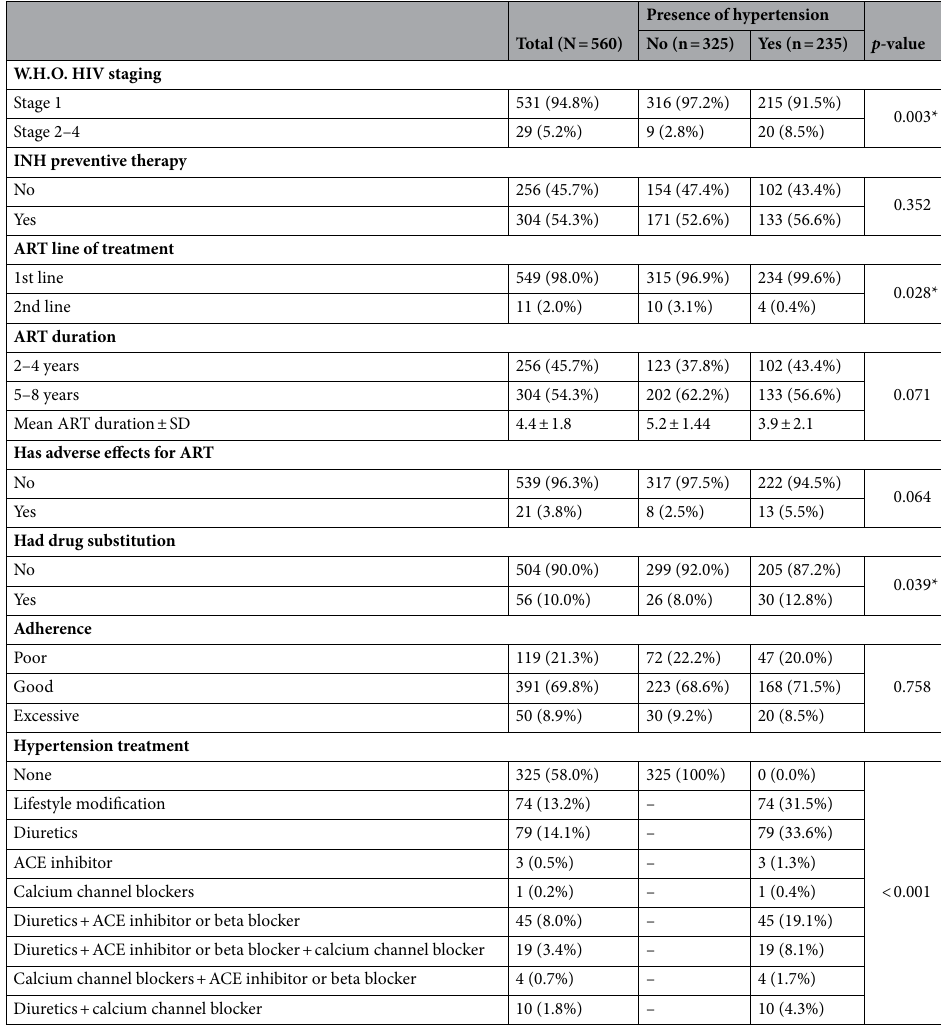
Table 2. Clinical characteristics of study participants. N: total study population; n: subset of study population; INH: isoniazid; W.H.O.: World Health Organization; HIV: human immunodeficiency virus; ART: antiretroviral therapy; –: irrelevant. *Statistically significant P-value.